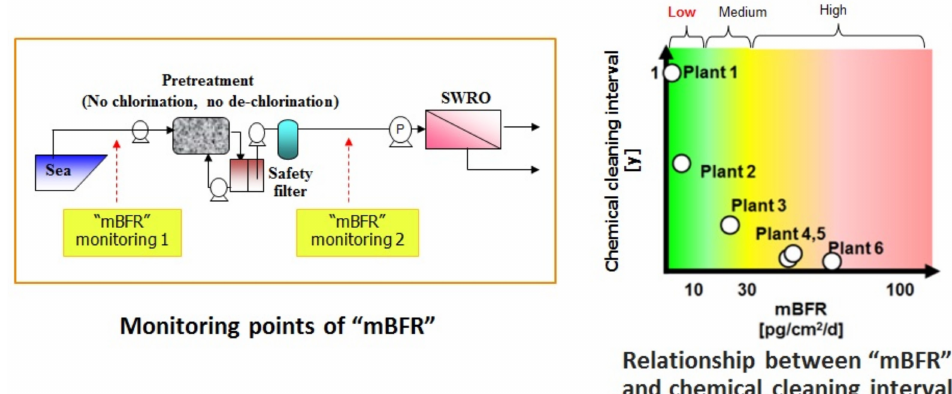
Figure 22. Quantitative RO chemical cleaning interval due to biofouling